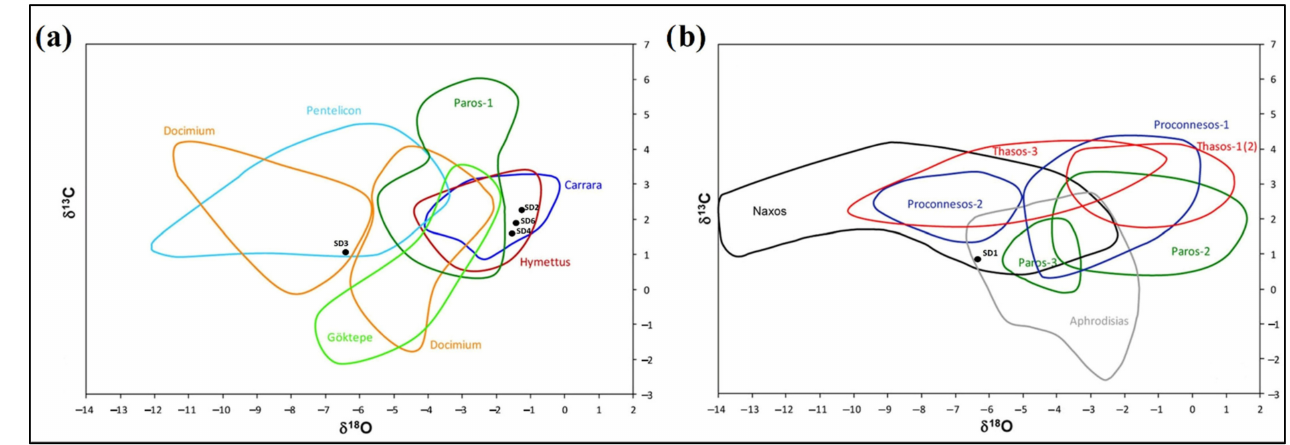
Figure 4. Comparison of the isotopic data about “Madonna della Febbre” samples and C and O stable isotope reference diagrams modified from [21] about the 10 most used Roman marbles for fine-grained ( a ) and medium to coarse ( b ) ones,